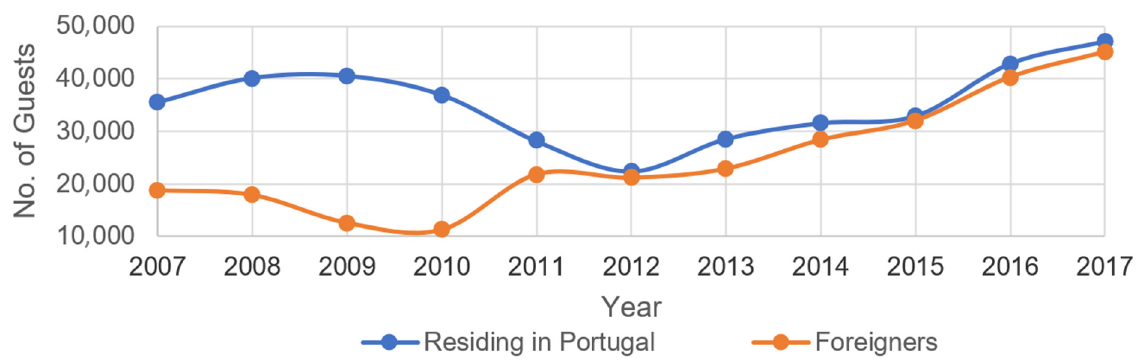
Figure 9. Guests entering Porto Santo. (Source: Authors).